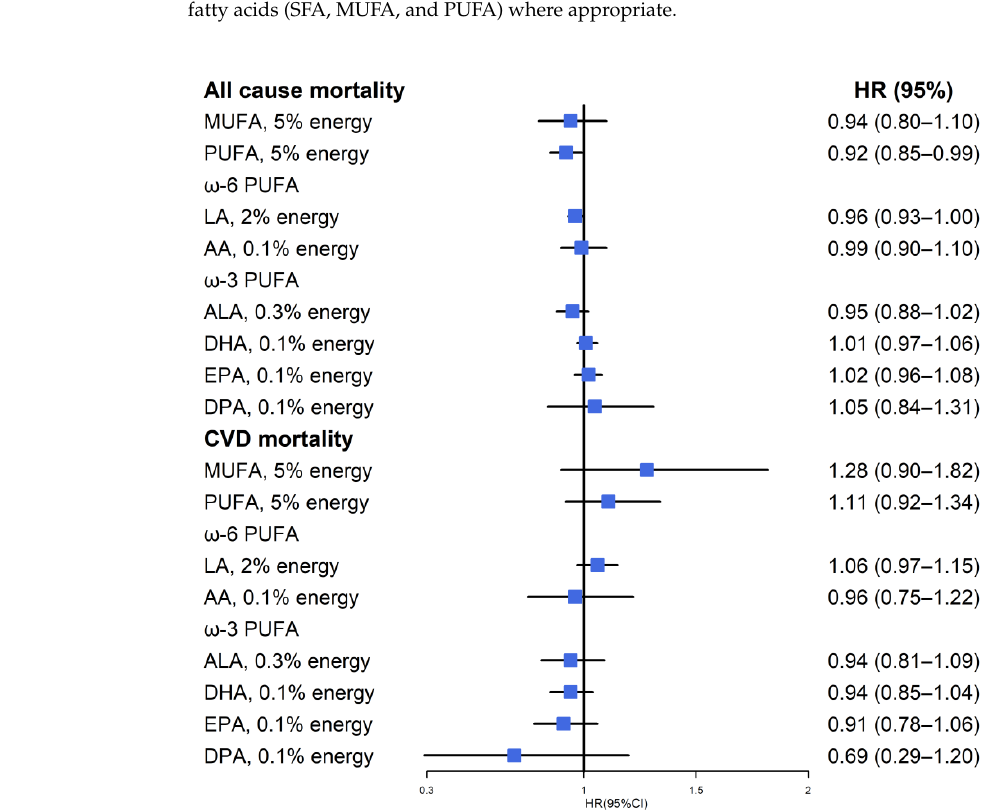
Figure 2. Multivariable hazard ratios (HRs) of all cause mortality and CVD mortality by isocaloric substitution of specific fatty acid for saturated fatty acids among participants with CMD in NHANESIII and NHANES 1999–2014.